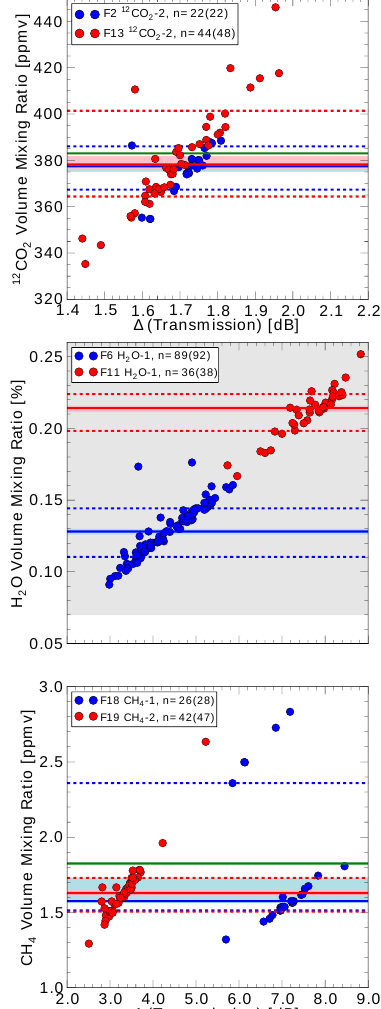
Figure 7. Examples of retrieved ensembles of volume mixing ratios within ∼ 10min periods for absorption lines of 12 CO 2 (top panel, data from files F2 and F13), H 2 O (middle panel, data from files F6 and F11), and CH 4 (bottom panel, data from files F18 and F19) as a function of the measured (cid:49) T (Eq. 1). Individual retrievals are shown (color-filled circles, one red and one blue example ensemble per panel) together with markers (horizontal lines and shaded areas) of the Tx/Rx-averaged CRDS reference value (green line, except for H 2 O), the CRDS reference data uncertainty range (gray-shaded area, almost covering the H 2 O panel and almost invisibly small for 12 CO 2 and CH 4 ), the median value of the retrievals (red/blue solid lines, partially overlapping), the ± 1 σ range of the retrievals (red/blue dotted lines about median, partially overlapping), and the √ ± σ/ n range of the retrievals (light red/light blue-shaded areas, partially overlapping). The number of individual retrievals per en- semble ( n ) is indicated in the legend both after the outlier rejection and before the outlier rejection (the latter shown as value in paren-